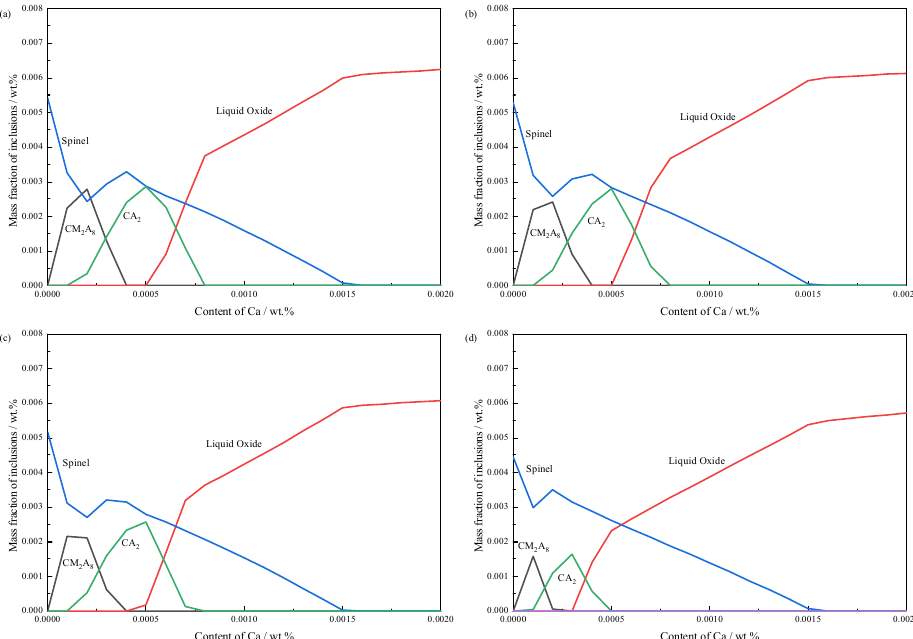
Figure 9. Effect of calcium content on inclusions in smelting process at 1600 ◦ C: ( a ) Al: 0.036%; ( b ) Al: 0.024%; ( c ) Al: 0.02%; ( d ) Al: 0.008%; C: 0.4%; Cr: 0.98%; Mo: 0.16%; Mg: 0.0006%; O: 0.003%; Spinel: MgO-Al 2 O 3 ; CM 2 A 8 : CaO-2MgO-8Al 2 O 3 ; CA 2 : CaO-2Al 2 O 3 ; C 2 S: CaO-2SiO 2 ).